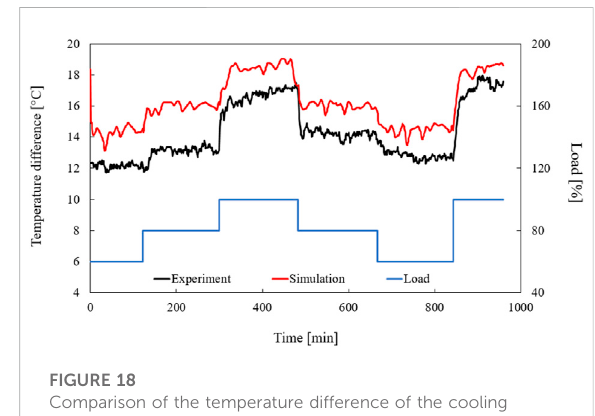
FIGURE 16 Temperature pro fi les of the dynamic simulation at different heights in the riser.